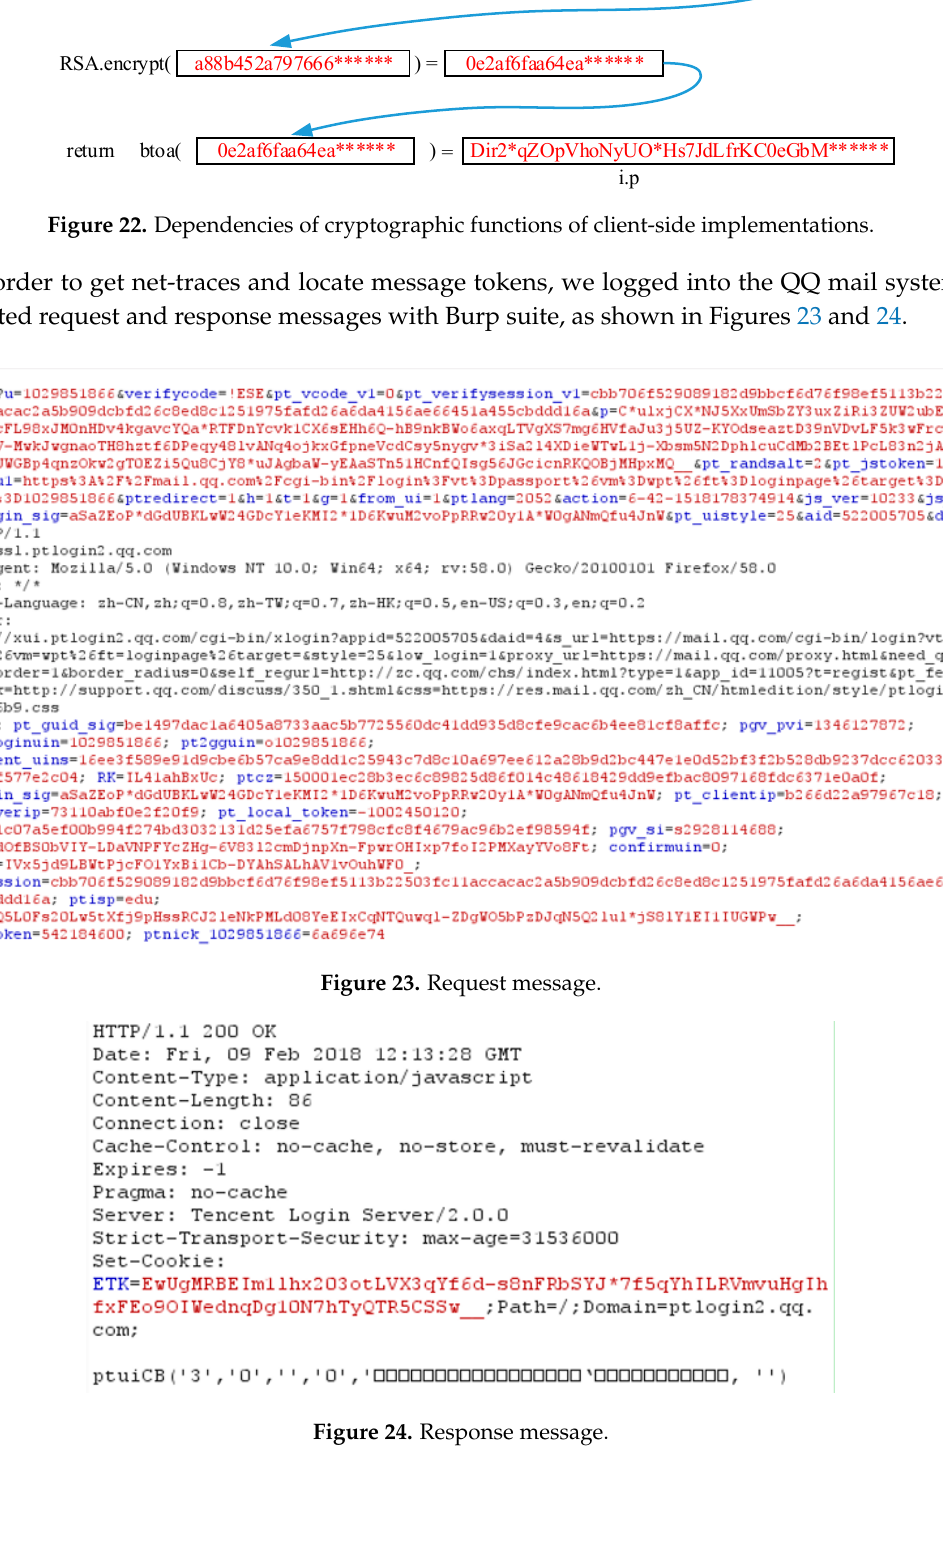
Figure 22. Dependencies of cryptographic functions of client-side implementations.